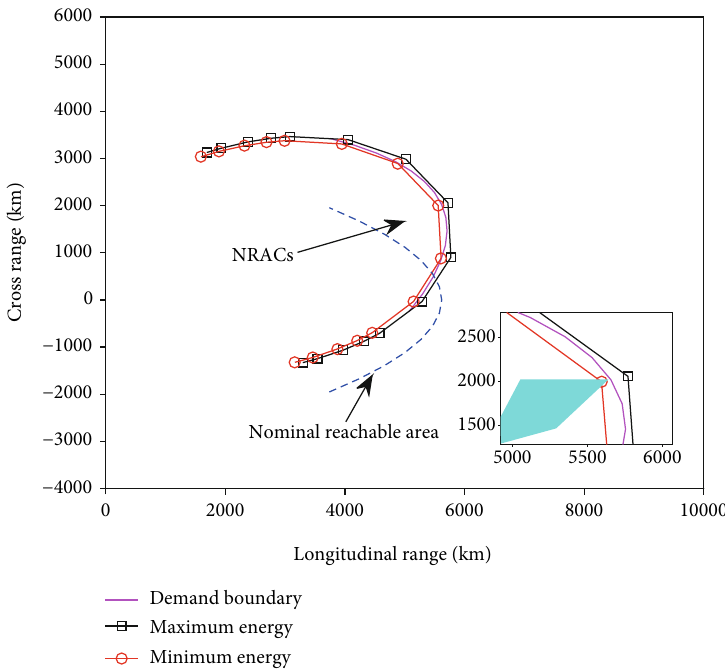
Figure 32: Comparison of the reachable